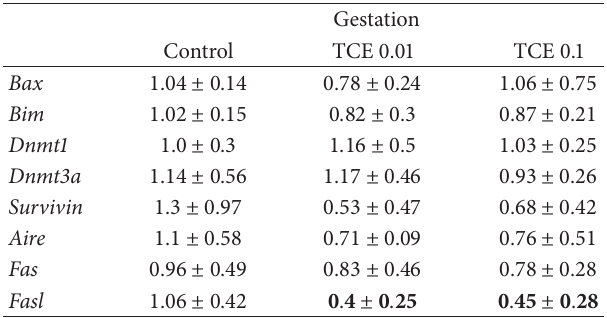
Table 3: Gene expression in thymi of mice exposed to TCE during gestation. Gestation Control TCE 0.01 TCE